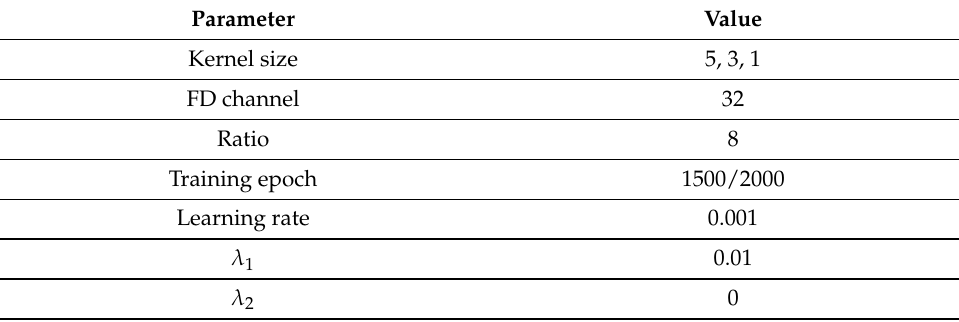
Table 1. Parameter settings for FD-Network and